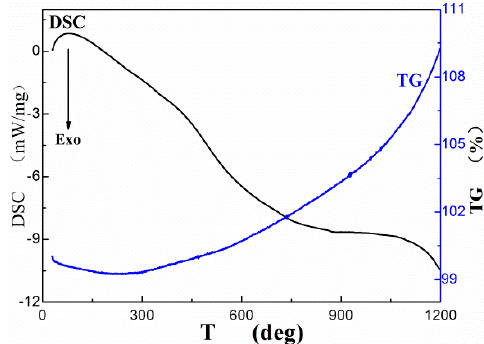
Figure 3. The TG and DSC test results of amorphous boron.